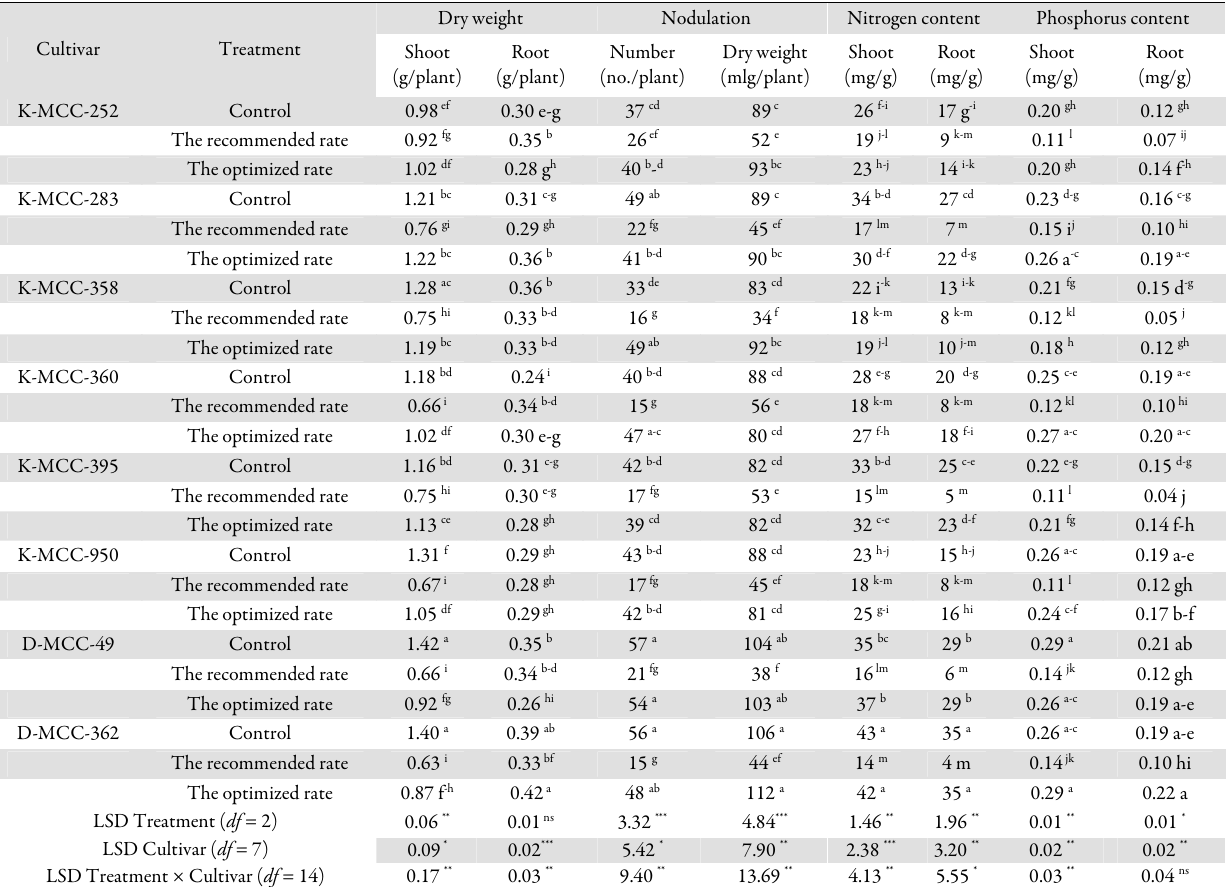
Tab. 2. Effect of the recommended and optimized rates of pyridate on biological properties of the chickpea cultivars inoculated with